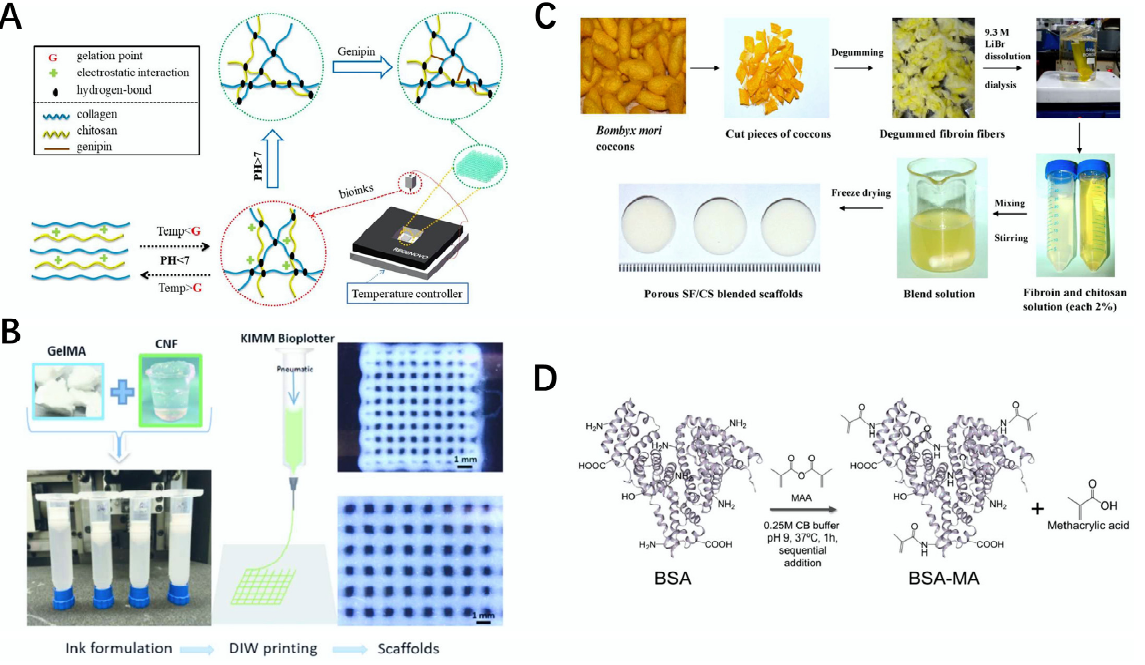
Figure 1. Schematic diagram of the preparation of some protein bioscaffolds and bio-inks. ( A ) Sche- ( A ) Schematic representation of the 3D printed Col–chitosan scaffold [15]. ( B ) Schematic dia- gram of the preparation of CNF/GelMA bio-inks and their use for 3D printing into scaffolds [16]. ( C ) Schematic diagram of the preparation of the SF–chitosan composite scaffold [17]. ( D ) Schematic diagram of the preparation of the BSA–MA hydrogel